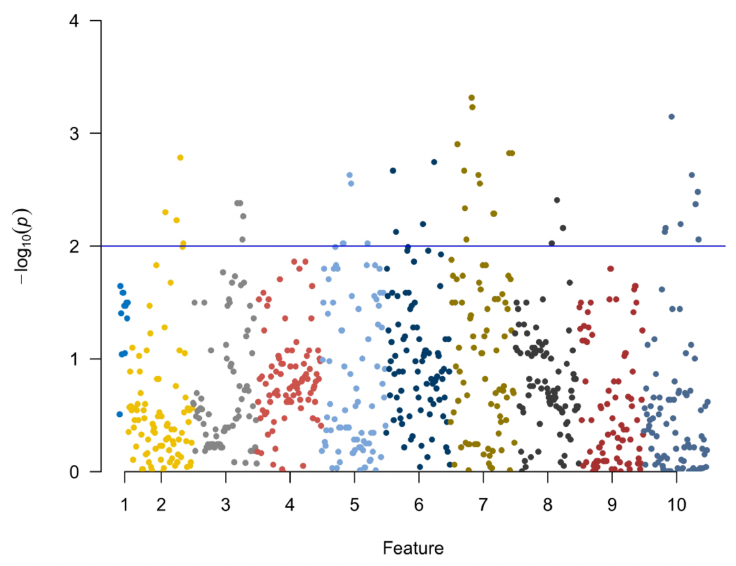
Figure 2. The p values of the 10 feature parameters and corresponding coefficients after screening in the first model are shown in this Manhattan plot.